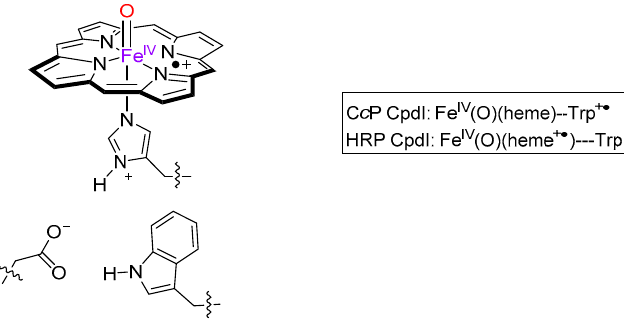
Figure 1. Active site structures of ( a ) horseradish peroxidase (HRP; 1H58 pdb), ( b ) cytochrome c peroxidase (C c P; 1CCA pdb), ( c ) ascorbate peroxidase (APX; 1OAF pdb).